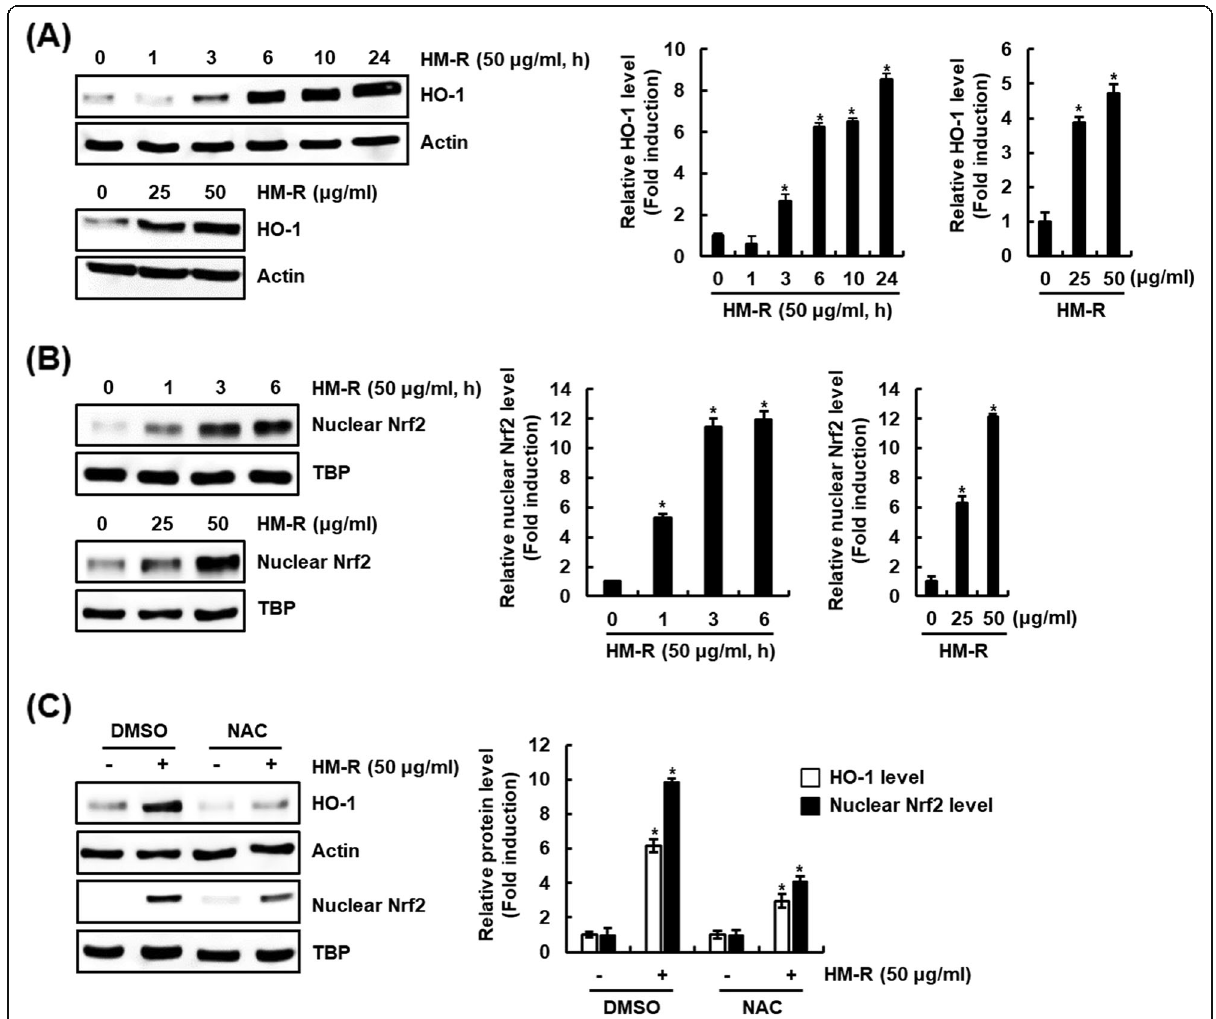
Fig. 4 Effect of HM-R on HO-1 expression through ROS-dependent Nrf2 activation. a RAW264.7 cells were treated with HM-R (50 μ g/ml) for the indicated times or indicated concentrations for 6 h. b RAW264.7 cells were treated with HM-R (50 μ g/ml) for the indicated times or indicated concentrations for 3 h. After treatment, nuclear fraction was prepared. c RAW264.7 cells were pretreated with NAC (10 mM) for 2 h and then co- treated with HM-R for 6 h for HO-1 analysis or for 3 h for nuclear Nrf2 anaylsis. For Western blot analysis, the cell lysates were subjected to SDS- PAGE and the Western blot was performed using antibodies against HO-1 and Nrf2. Actin or TBP was used as internal control for Western blot analysis. The density of Western blot bands was calculated using the software UN-SCAN-IT gel version 5.1 (Silk Scientific Inc. Orem, UT, USA). *P